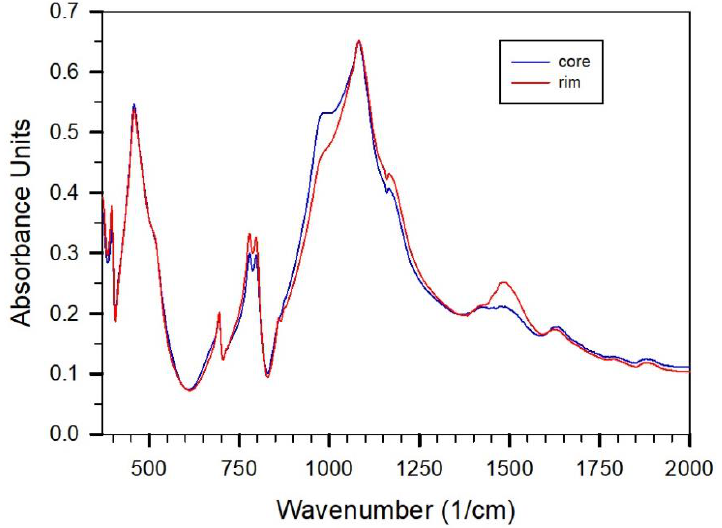
Figure 1. IR absorption spectra of a freshly prepared lime-sand brick probed in the rim and core showing the beginning of carbonation from outside to inside of the brick.